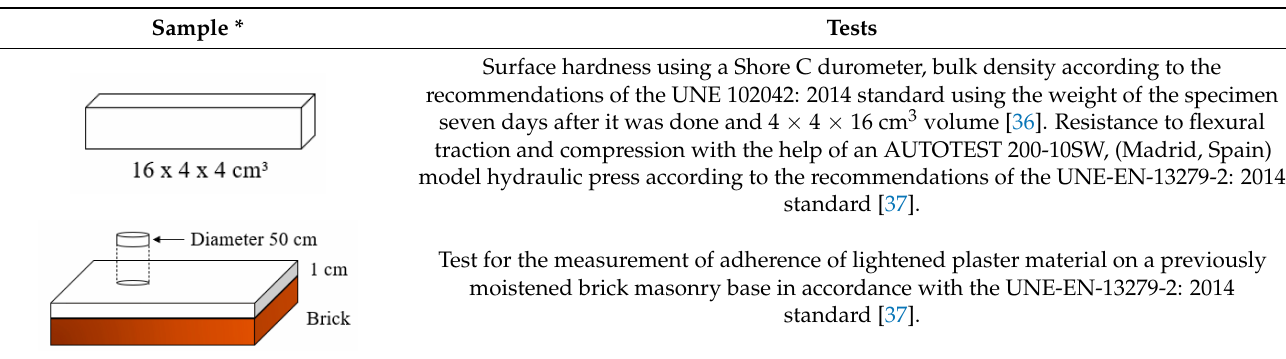
Table 1. Relationship between tests and samples